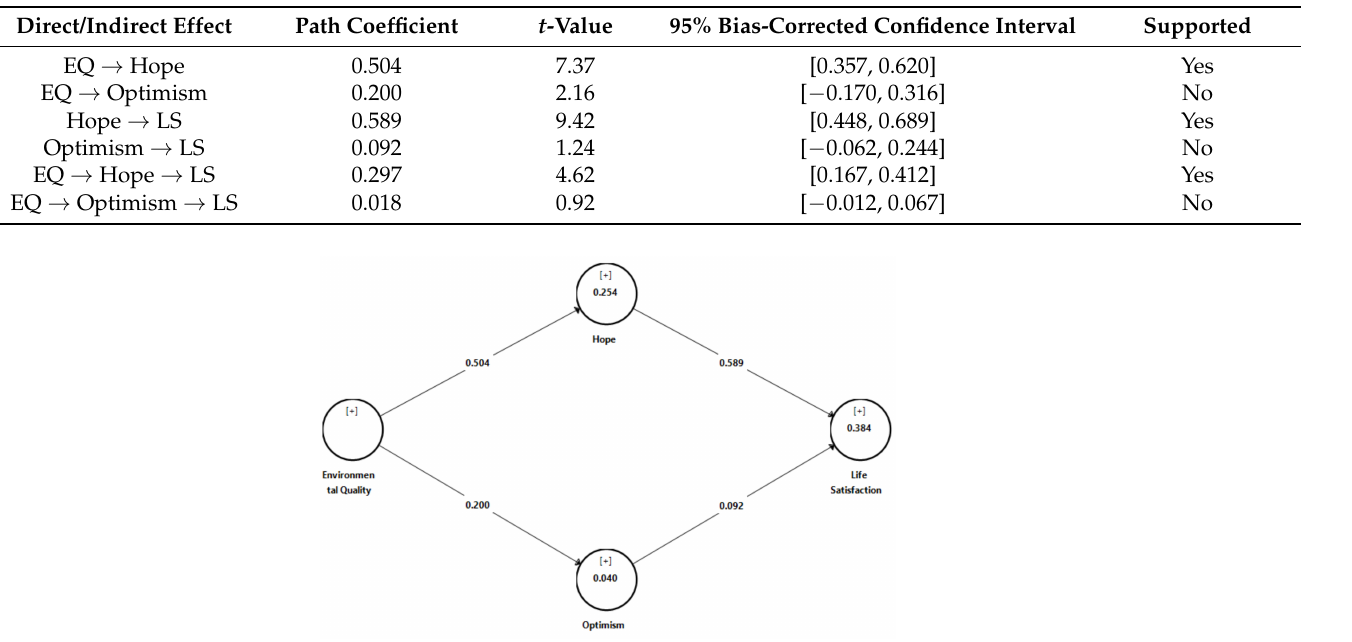
Table 4. Results of hypothesis testing.